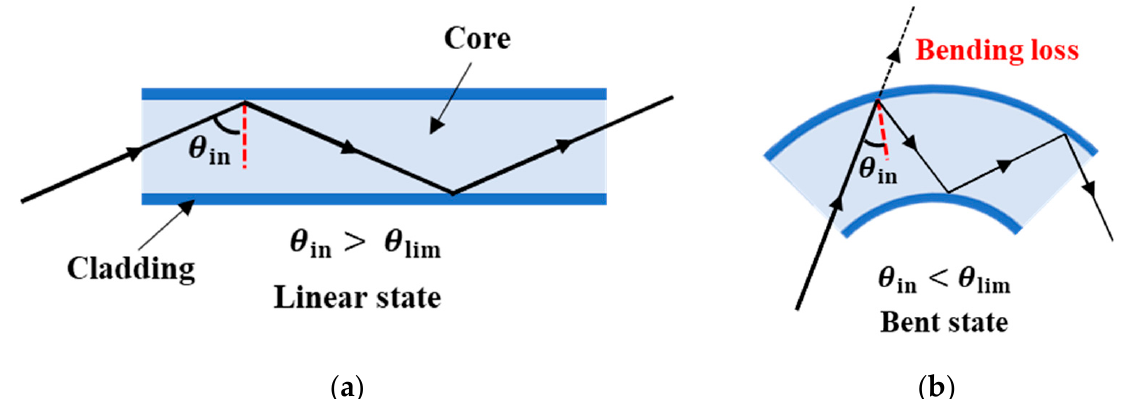
Figure 5. Bending loss of the optical fiber: ( a ) linear state; ( b ) bent state.